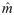
No consistent change in the distance to criticality before seizure onset.a Time-resolved estimation of m^ for the full MTL within the last 10 min prior to seizure onset showed variability, but no consistent behavior during the last minutes before seizure onset. Plots show example traces of multiple seizures from one patient. Each trace corresponds to one pre-seizure period, shown both for the ipsilateral and the contralateral hemisphere. Traces of all patients and seizures shown in S6 Fig. b No significant difference in the distance to criticality between the last 5 min prior to seizure onset and the previous 5 min—neither in the MTL containing the epileptic focus, nor in the contralateral one (p-values of Wilcoxon signed rank test). c Separate analysis of the individual subregions of MTL. Within none of the subregions there were significant differences between the last 5 min before seizure onset and the previous 5 min. Box plots in c show results from the hemisphere containing the epileptic focus. d Variability of the time-resolved branching parameter m^(t) in the last 5 min prior to seizure onset and the previous 5 min. Variability is quantified using the median absolute deviation from the median logarithmic distance to criticality (p-values of Wilcoxon signed rank test).